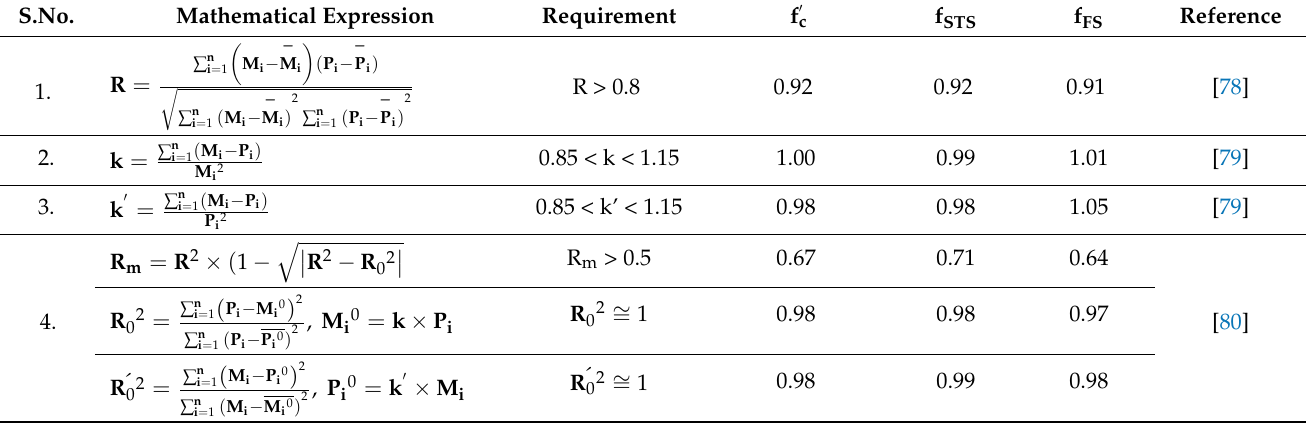
Table 5. Statistical indicators for verifying the external predictability of proposed MEP